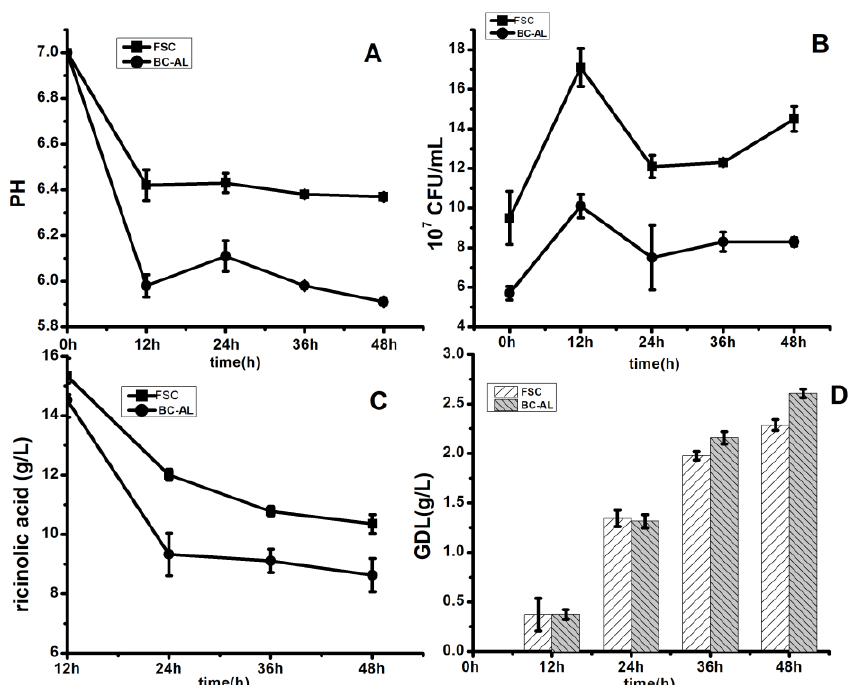
Figure 5. Changes in pH ( A ), cell growth ( B ), ricinoleic acid RA ( C ), and GDL concentration ( D ) in one-batch biotransformation with free suspended culture (FSC) and BC-ALG carriers.